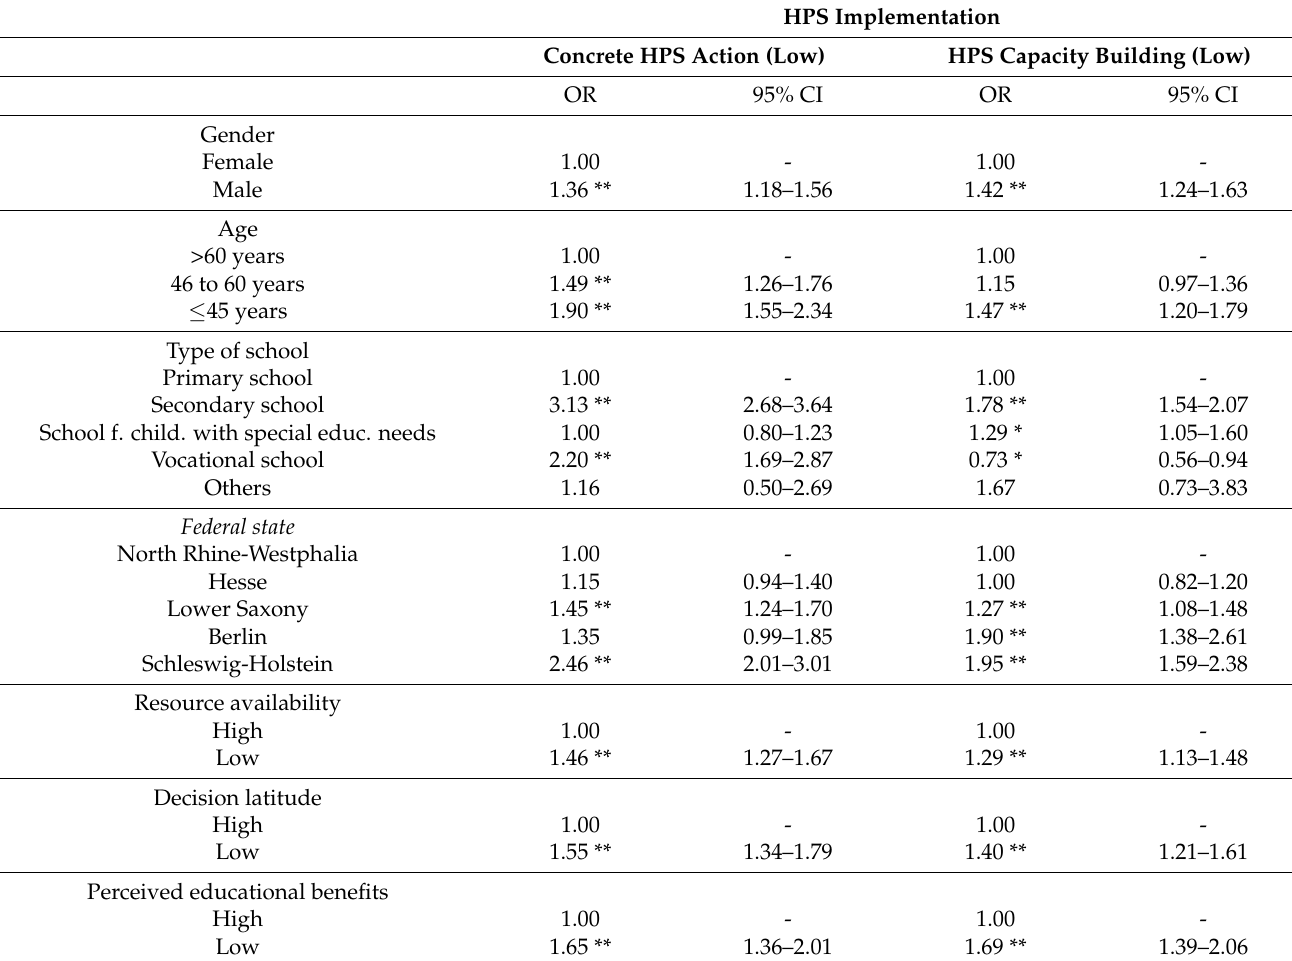
Table 5. Multiple binary logistic regression analysis for dimensions of HPS